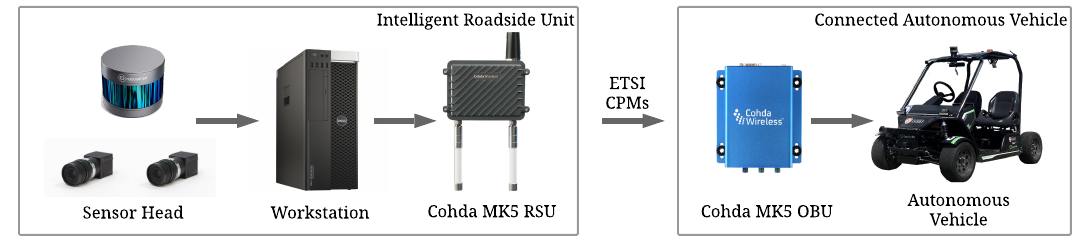
Figure 7. Perception information flow from the IRSU to the CAV. The IRSU broadcasts perceived objects information in the form of ETSI CPMs through the Cohda Wireless MK5 RSU. As the receiving agent, the CAV has V2X communication capability through the Cohda Wireless MK5